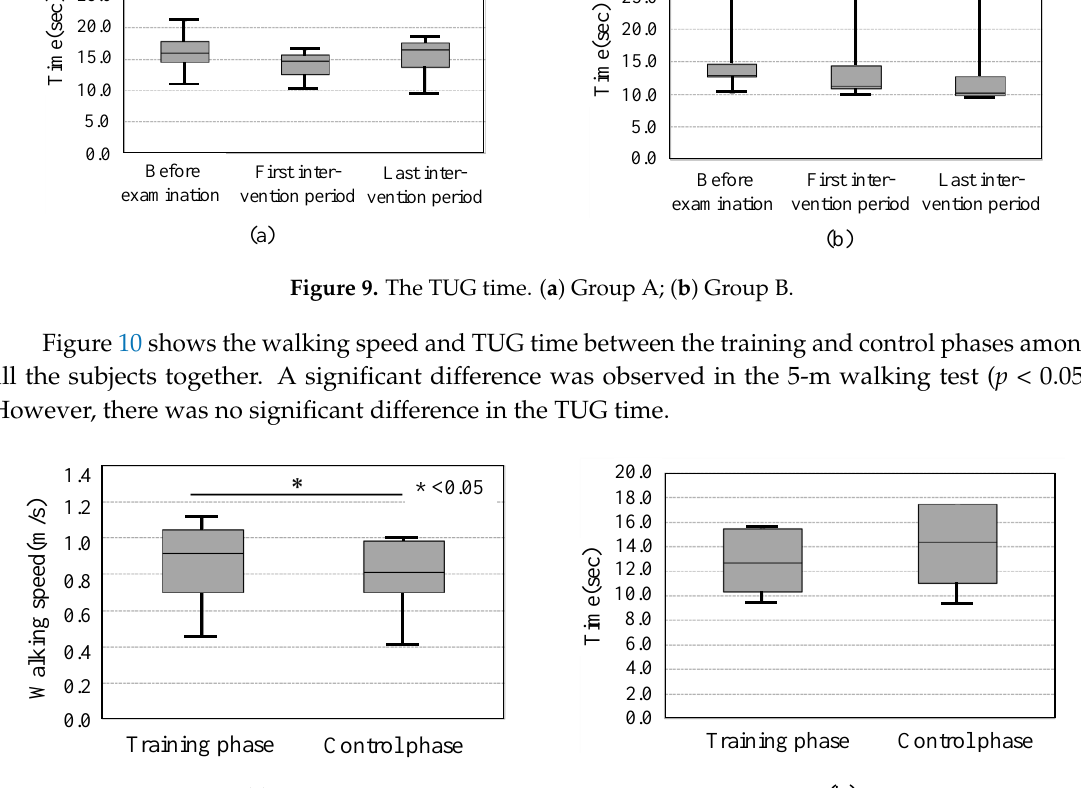
Figure 5. Walking speed during 5-m walking test. ( a ) Group A; ( b ) Group B